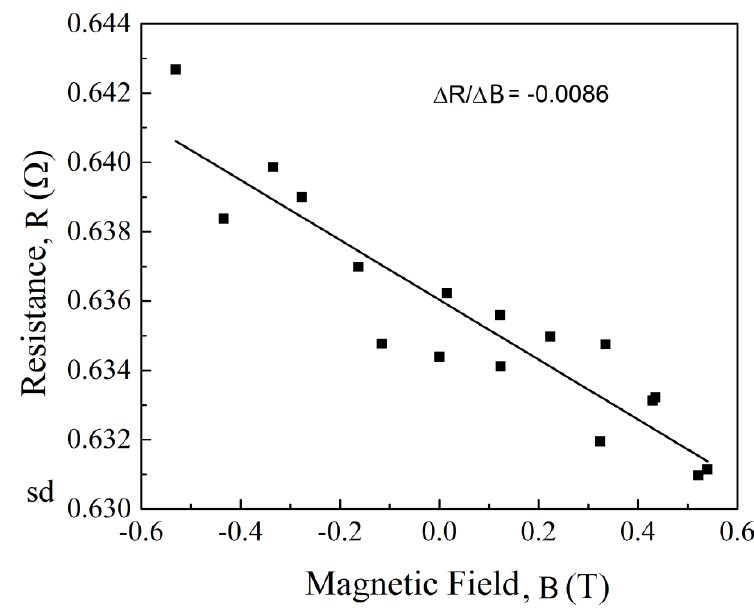
Figure 4. Resistance vs. magnetic field of CNT film.